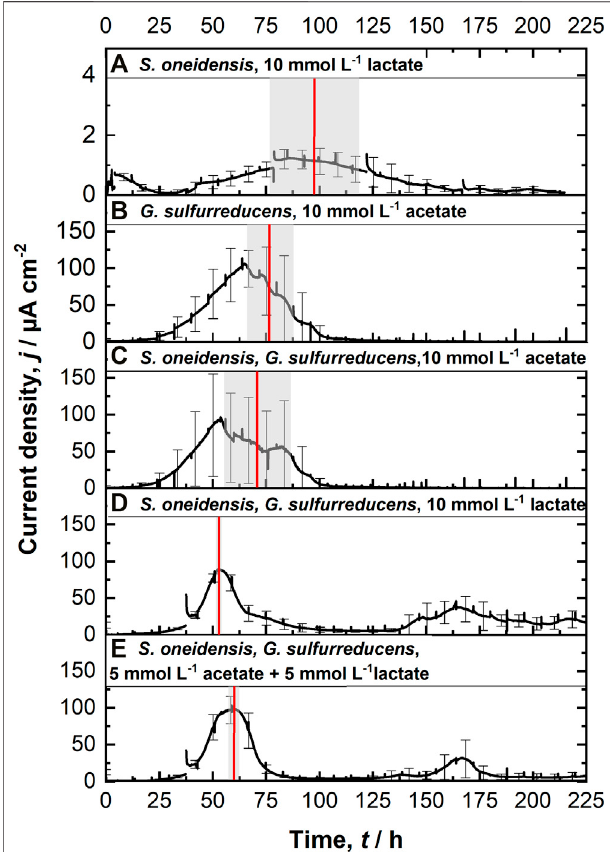
FIGURE 2 | Chronoamperometric measurements (CA) at 0.4 V vs. SHE using the ec-MP with each run being independently performed in one well using a three electrode setup: (A) S. oneidensis with 10 mmol L − 1 lactate ( n = 8); (B) G. sulfurreducens with 10 mmol L − 1 acetate as ED ( n = 8), as well as co-cultivations of S. oneidensis and G. sulfurreducens with (C) 10 mmol L − 1 acetate ( n = 10), (D) 10 mmol L − 1 lactate ( n = 8), and (E) 5 mmol L − 1 lactate + 5 mmol L − 1 acetate as ED ( n = 8). The time when maximum current density is reached t max (red line, calculated) as well as their standard deviation (grew box) is included. For a better clari fi cation of the high degree of reproducibility, see Supplementary Figure S7